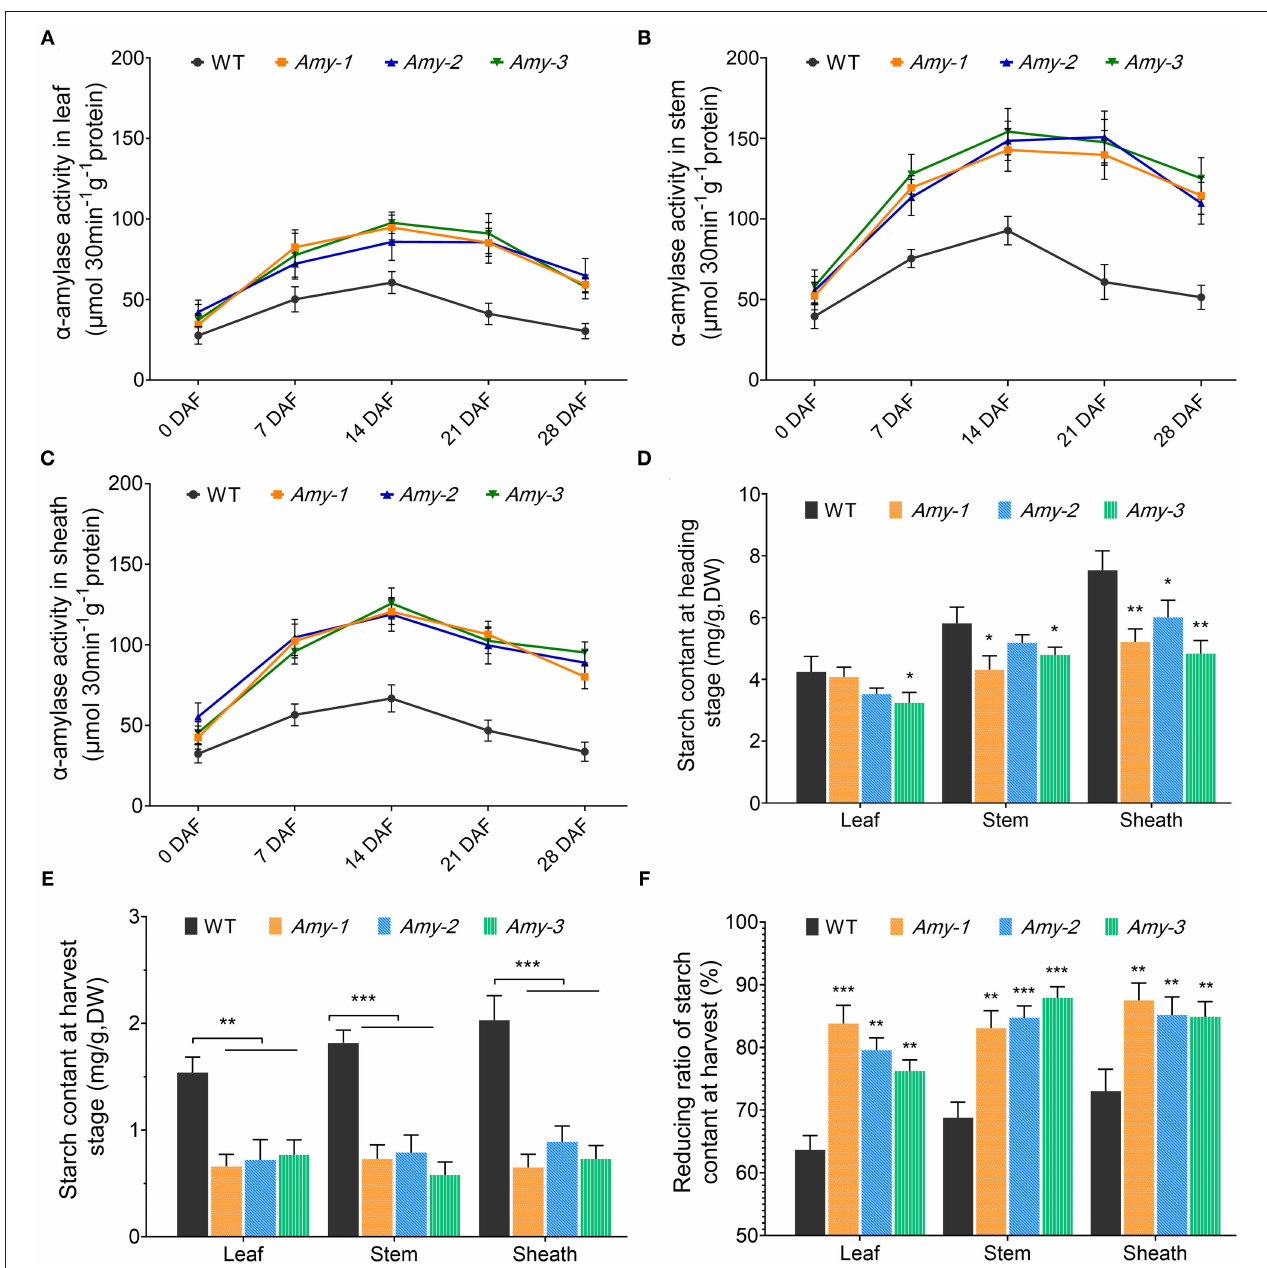
FIGURE 4 | α -amylase activity and starch content in source tissues. (A – C) α -amylase activity in rice leaf, stem, and leaf sheath at the grain filling stage. (D,E) Starch content in source tissues at the heading and harvest stages. (F) Reducing ratio of starch content in source tissues at harvest. Asterisks indicate significant differences compared with WT, as determined by Student’s t -test. * P < 0.05; ** P < 0.01; *** P < 0.001. Bars indicate standard deviations in three independent